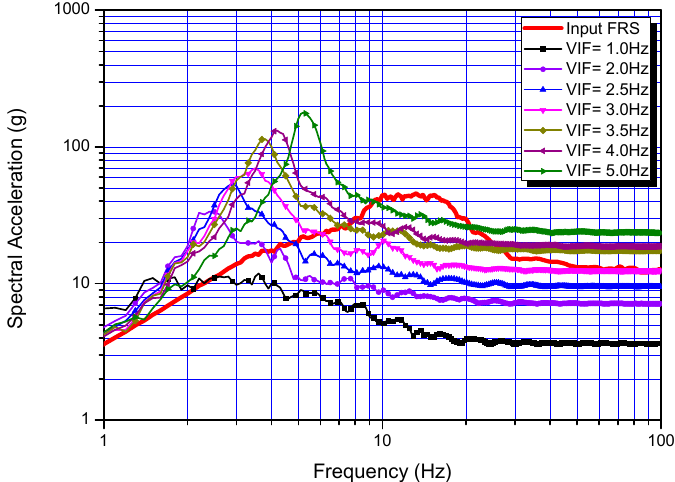
Figure 5. Spectral acceleration response of superstructure for various design VIF.